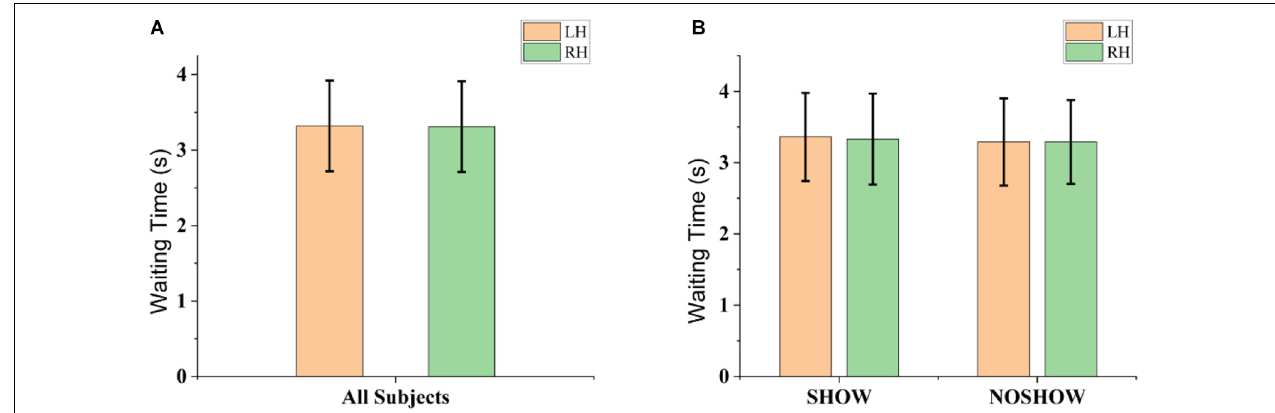
FIGURE 3 | Behavioral indicators of performance during instructed action. (A) Grand-averaged latency from the cue onset to EMG onset for the LH and RH. (B) Grand-averaged latency from the cue onset to EMG onset for the SHOW and NOSHOW groups for the LH and RH. Data are reported as the mean ± SD.